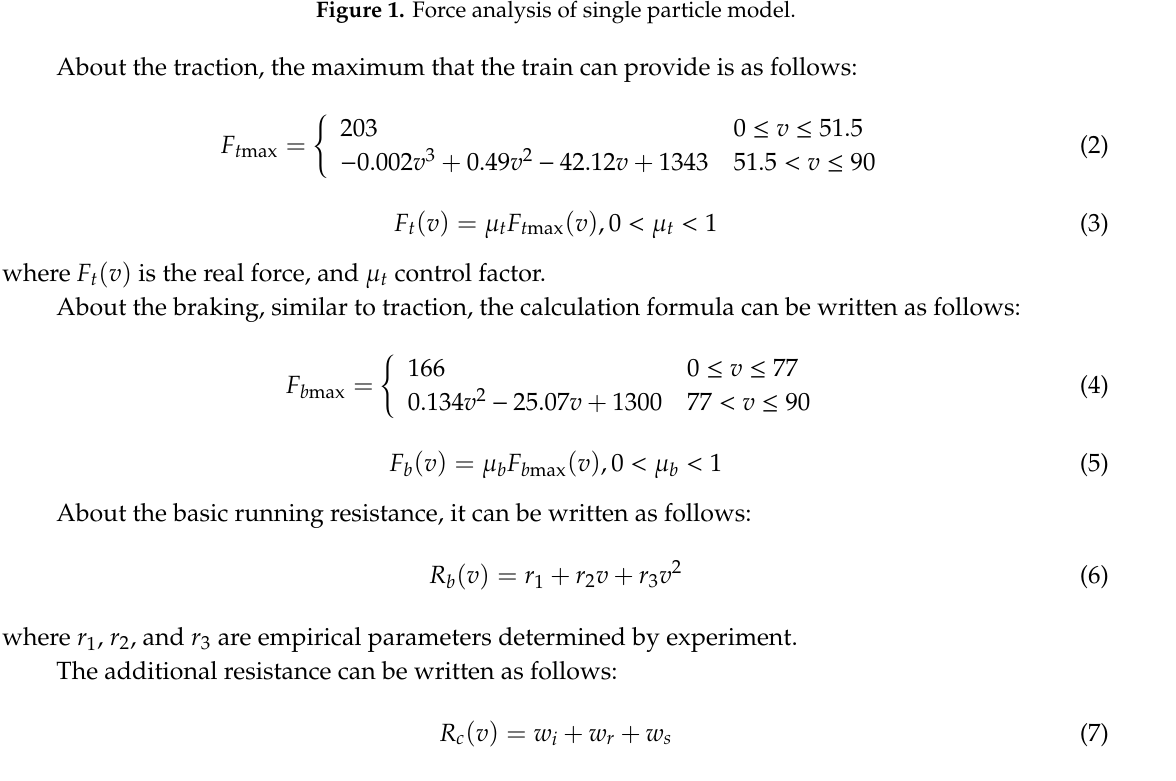
Figure 1. Force analysis of single particle